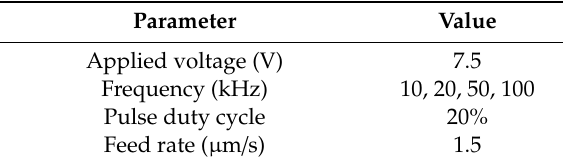
Table 2. Machining parameters with different pulse frequency.